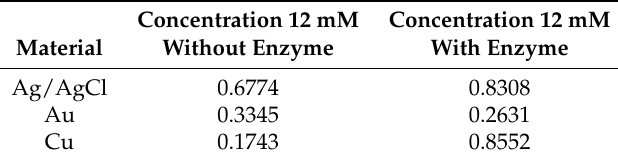
Table 6. Normality test— p -values for concentration of 12 mM.